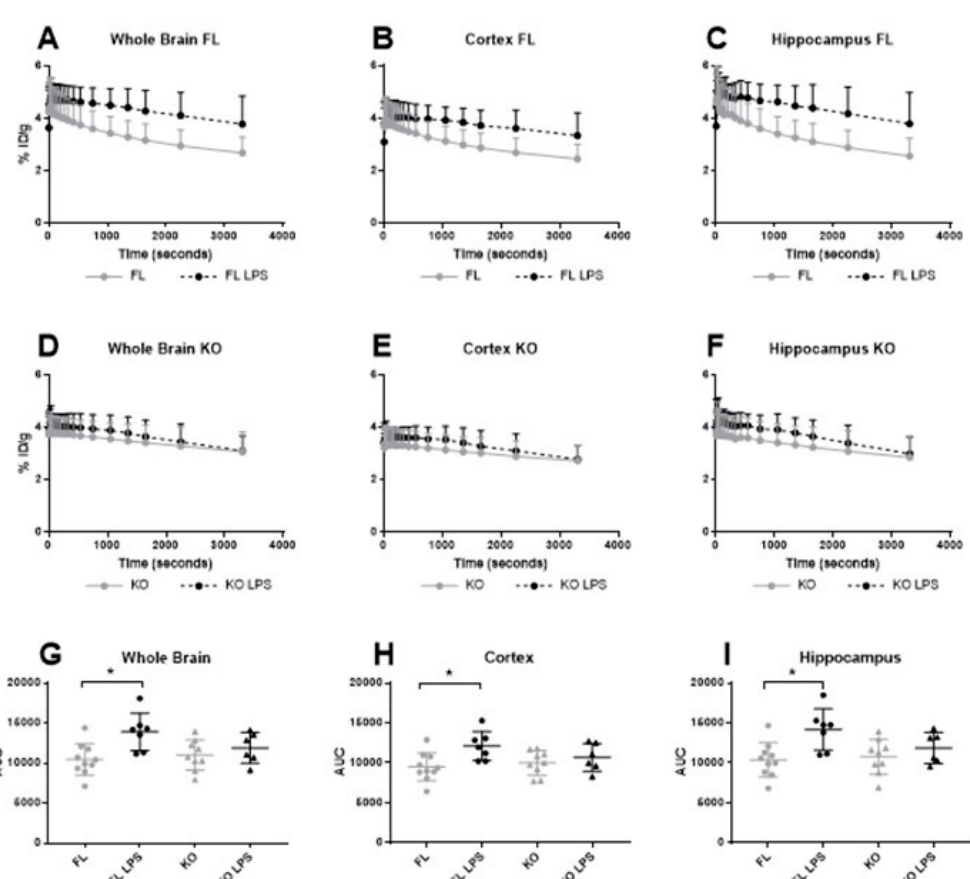
Figure 2. Time activity curve and the area under curve (AUC) of [ 18 F]FEPPA in the whole brain ( A , D , G ), the cortex ( B , E , H ) and in the hippocampus ( C , F , I ) in floxed and deleted Cx43 mice with or without LPS injection 24 h before imaging. [ 18 F]FEPPA Time Activity Curves (TAC) (in %Injected Dose / g) and the AUC (%ID × g − 1 × s − 1 ) before and after LPS injection in FL and KO Cx43 mice (n = 6–10). ( A , D , G ) [ 18 F]FEPPA in the whole brain before and after LPS injection in FL and KO mice. ( B , E , G ) [ 18 F]FEPPA in the cortex before and after LPS injection in FL and KO mice. ( C , F , I ) [ 18 F]FEPPA in the hippocampus before and after LPS injection in FL and KO mice. A one-way ANOVA test has been used for comparison between groups. * p <